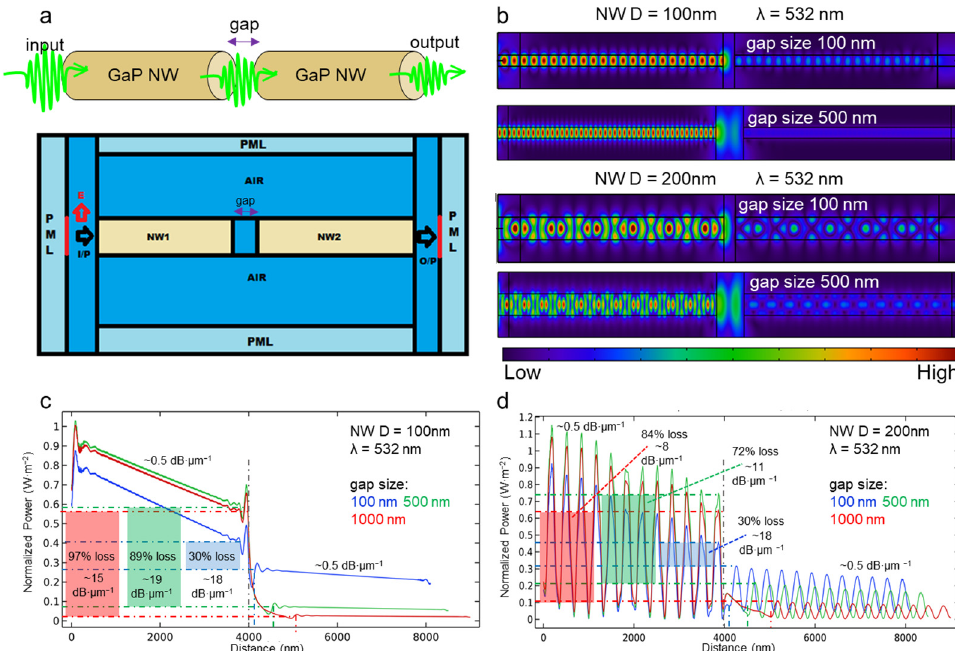
Figure 3. Simulation of the light propagation through two aligned GaP NW waveguides: ( a ) system schematics and geometry of the simulation, mesh size 1nm, ( b ) field patterns (normalized electric field distribution) for the system configurations with 100 nm and 200 nm thick master-slave NWs, 100 nm and 500 nm gap between them, ( c ) light power distribution along the 100 nm thick NWs for three different gaps, and ( d ) light power distribution along the 200 nm thick NWs for three different gaps (Input power = 1 W/m 2 ).